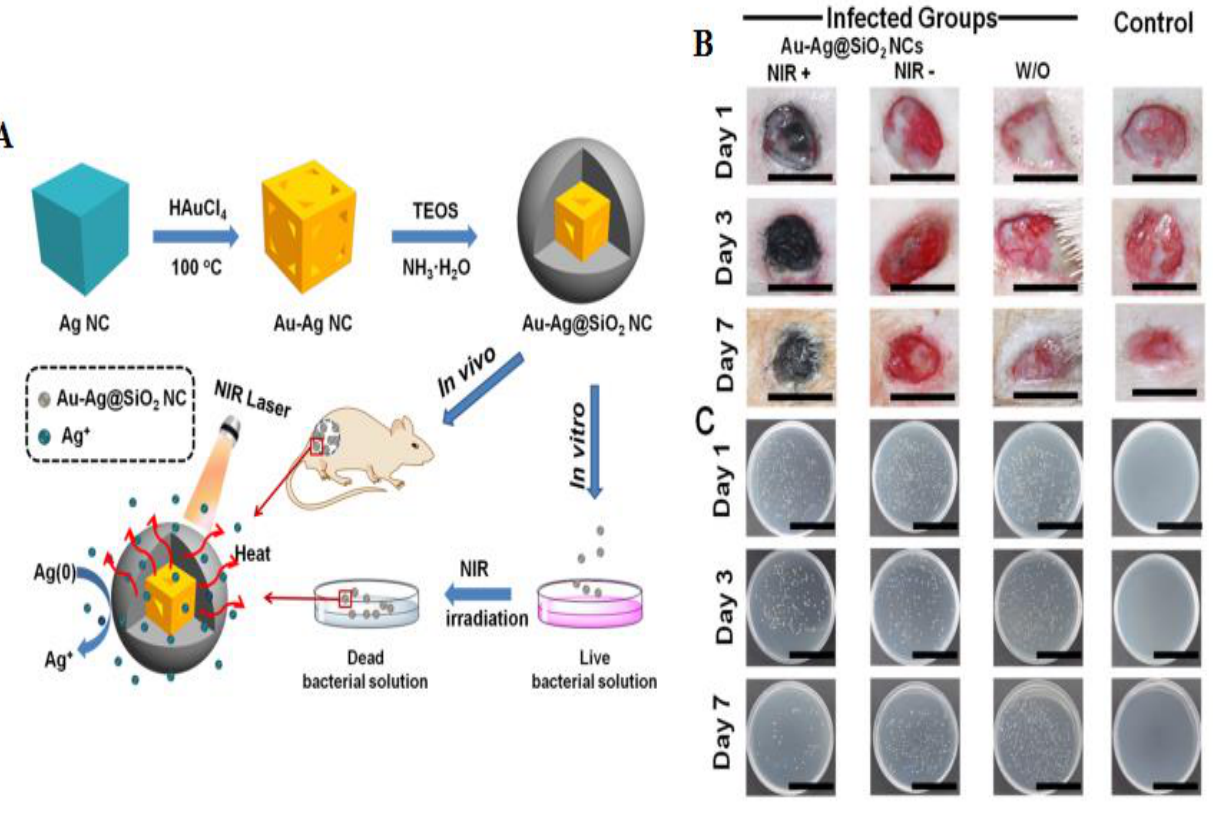
Figure 6. Schematic illustration of the Silica-coated Au-Ag nanocages displays antibacterial activity through photothermal activity ( A ). Schematic of wound tissues with various treatments on three days ( B ). Photographs of bacterial colonies from tissues of various treatment groups ( C ) Reprinted with permission from [157] . Copyright 2022 American Chemical Society.